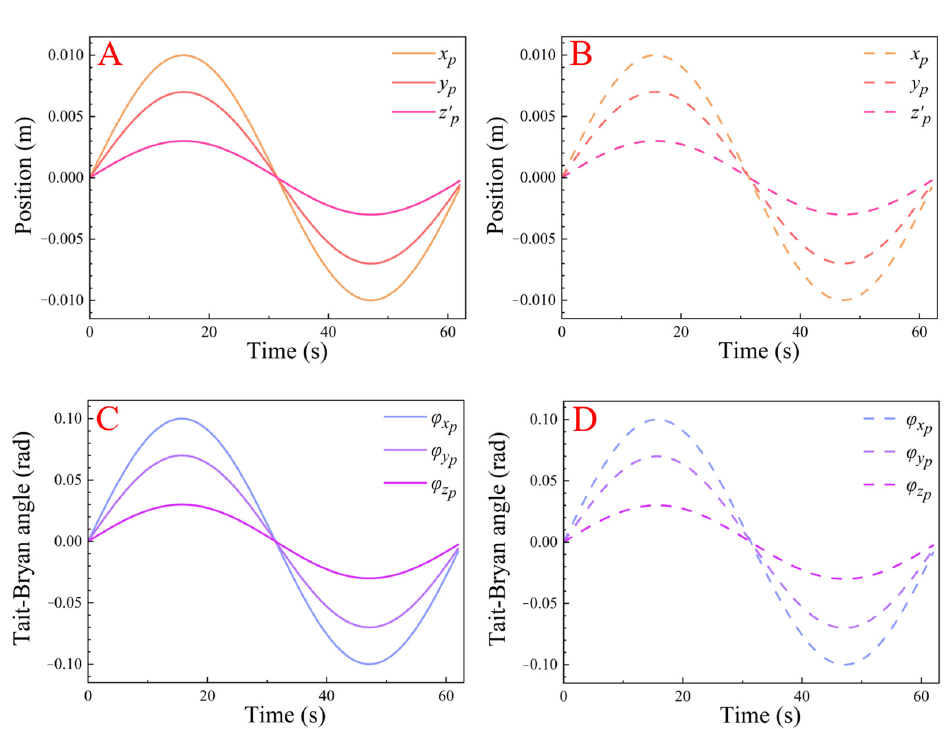
Figure 6. Comparison of trajectories: ( A ) given position trajectory, ( B ) ADAMS outputs position trajectory, ( C ) given attitude trajectory, and ( D ) ADAMS outputs attitude trajectory.